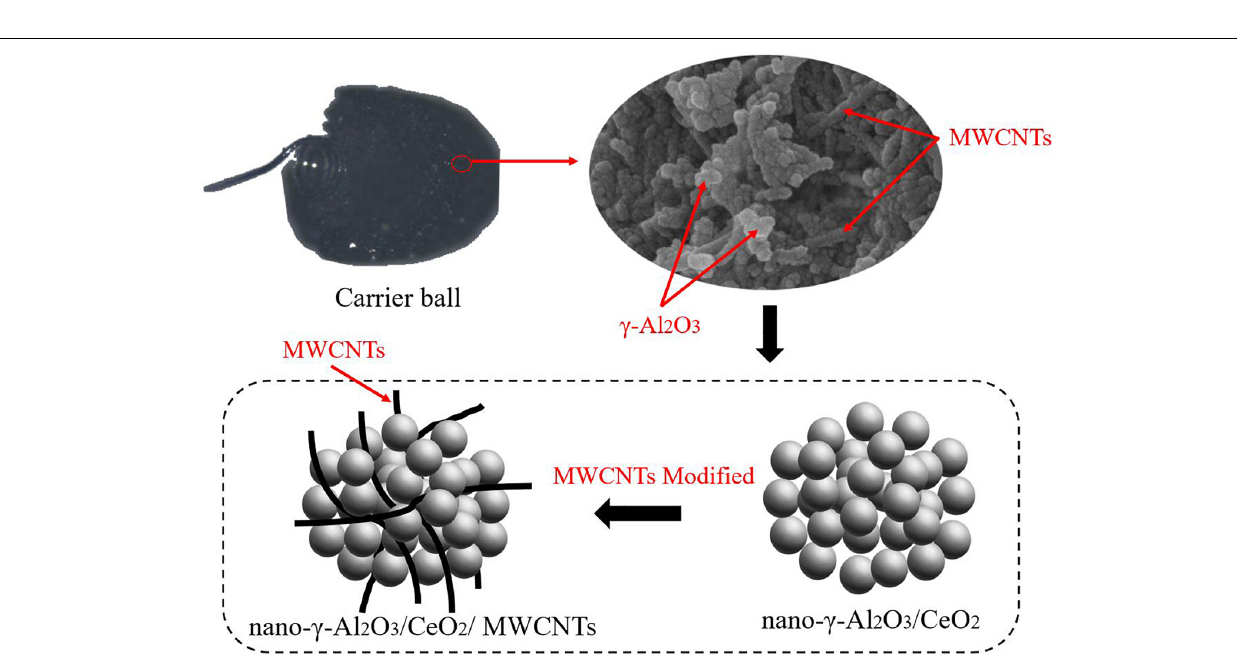
FIGURE 12 | Response curves of 30% CO 2 compared with non-MWCNTs-modified sensor and commercial sensor MD62.